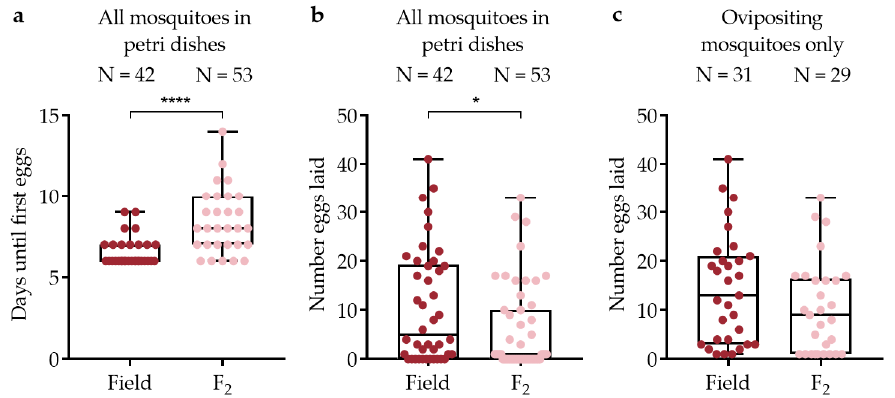
Figure 5. Egg development and oviposition for individually maintained field collected (Field) and F 2 mosquitoes. Box plots show median values and IQR for ( a ) number of days until first eggs were laid; ( b ) number of eggs laid per mosquito for all mosquitoes in Petri dishes; and ( c ) number of eggs laid